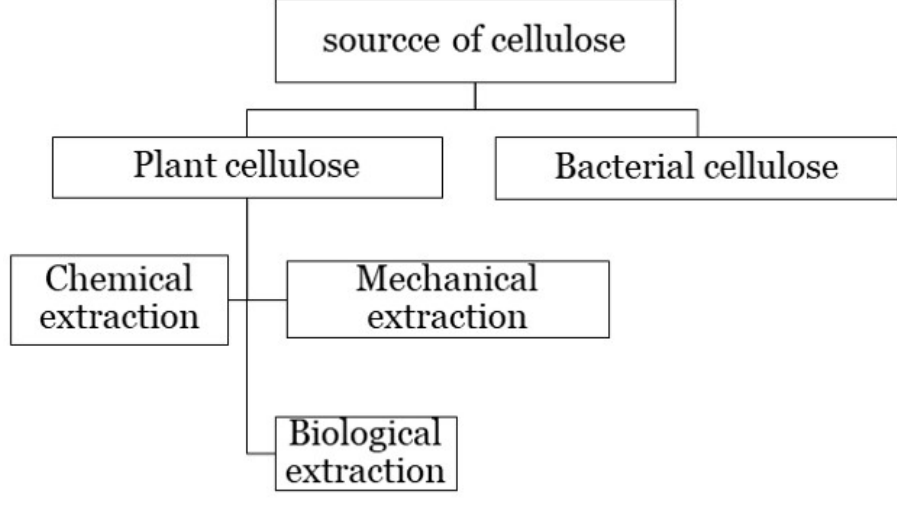
Figure 4. Cellulose source.